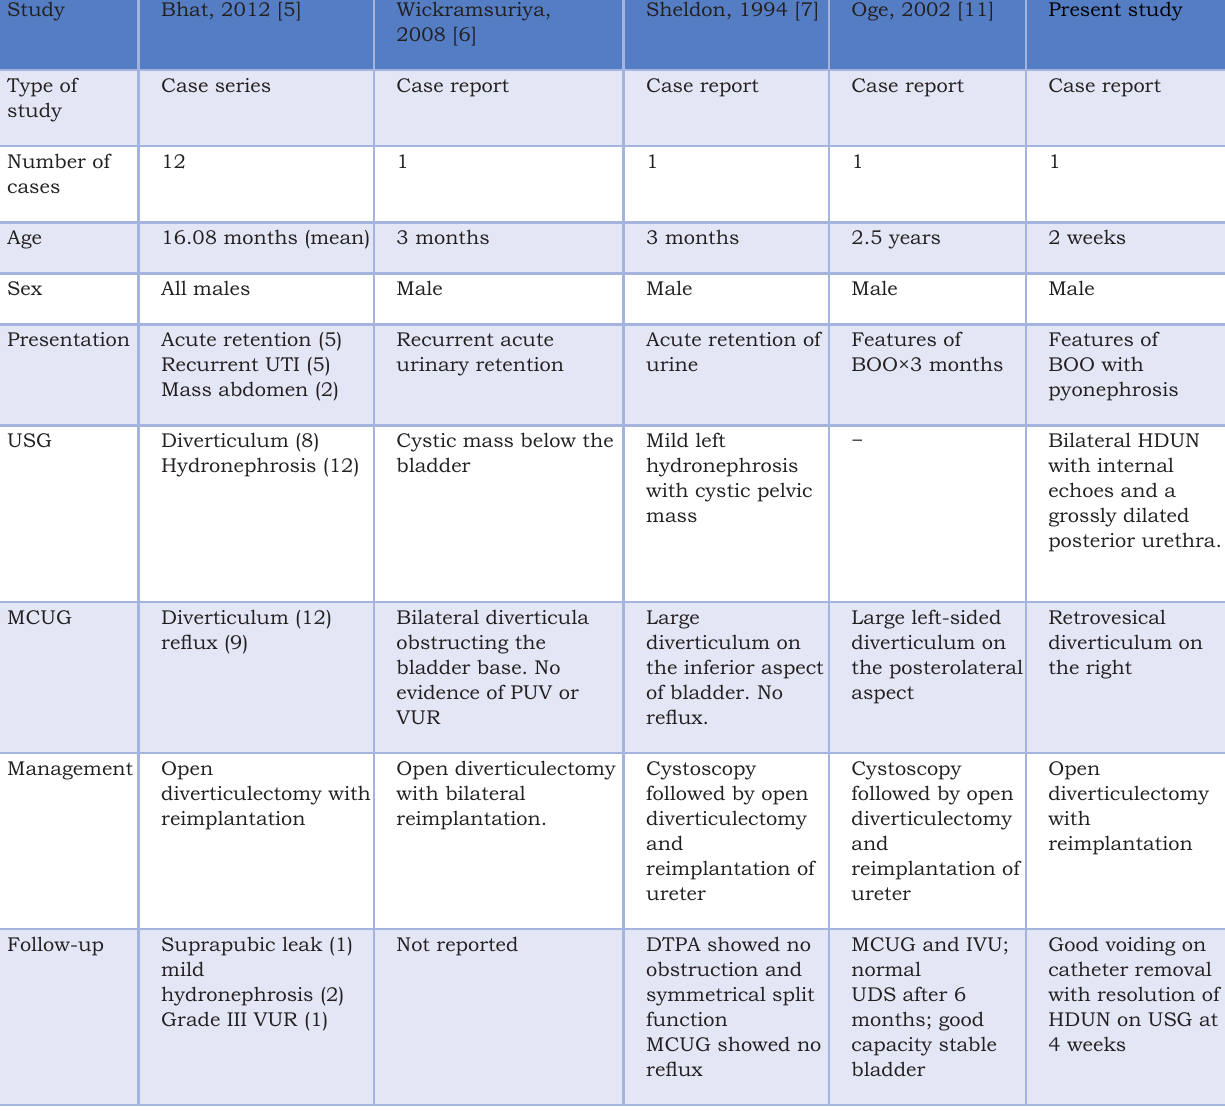
Table 1: Comparison between the cases reported in literature [7,8-11]